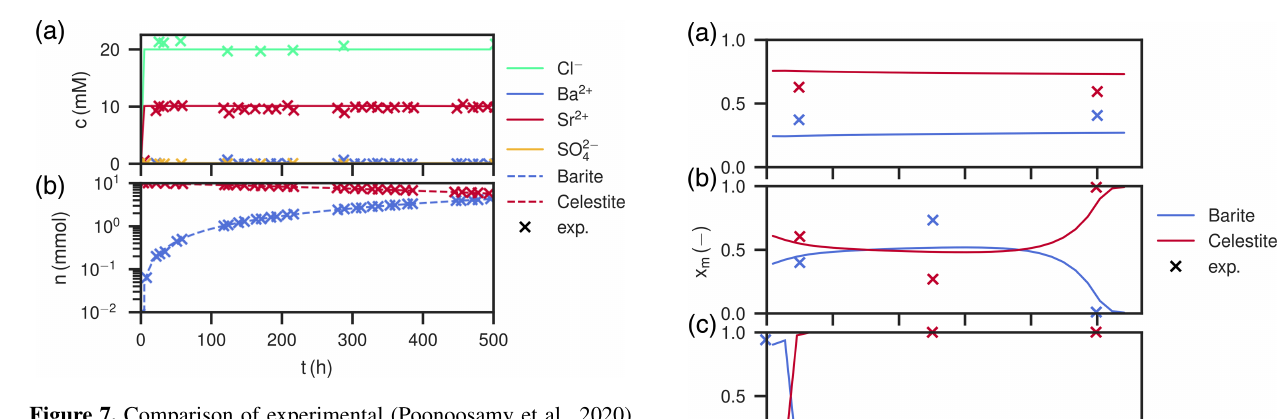
Figure 7. Comparison of experimental (Poonoosamy et al., 2020) and simulation results for barium input concentration Ba 2 + = 10mM. (a) Breakthrough curves of the effluent, i.e., the chemi- cal composition (Ba 2 + , SO 2 − , Sr 2 + , Cl − ) of the last cell over the 4 course of the experiment. (b) Total barite and celestite phase amount in the column over the course of the experiment. Figure 9. Mole fractions of barite and celestite in the col- umn after the duration of experiments one (a) , two (b) and three (c) . Shown are also mole fractions derived in the experimen- tal study (Poonoosamy et al., 2020). Only barite and celestite are present in the